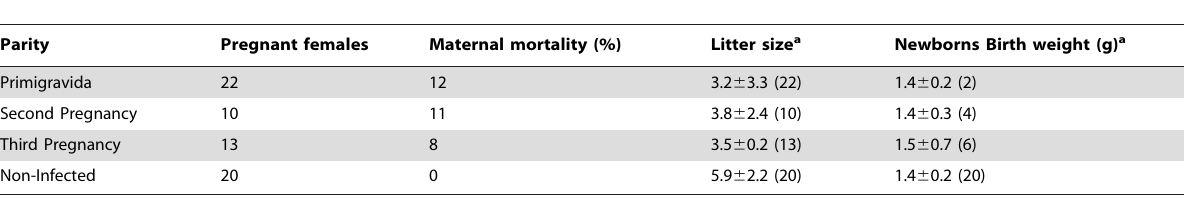
Table 2. Disease severity and pregnancy outcome in non-recrudescent females according to parity.